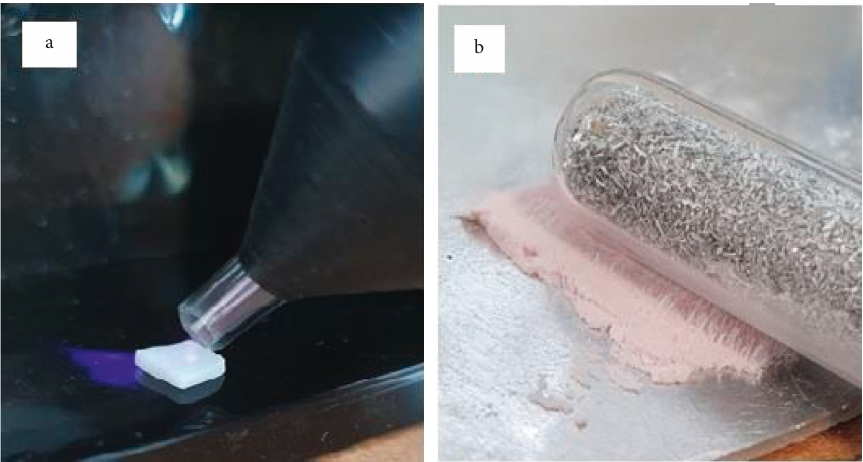
Figure 1: Application of nonthermal helium plasma on (a) zirconia core and (b) veneering ceramic powder.